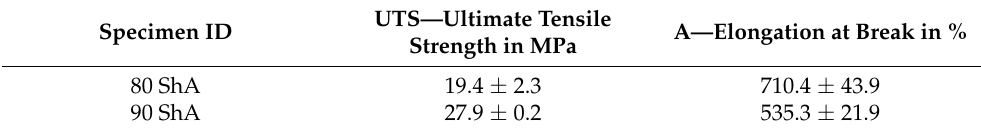
Table 1. Tensile test results analysis for 80 ShA and 90 ShA material configuration based on [21].